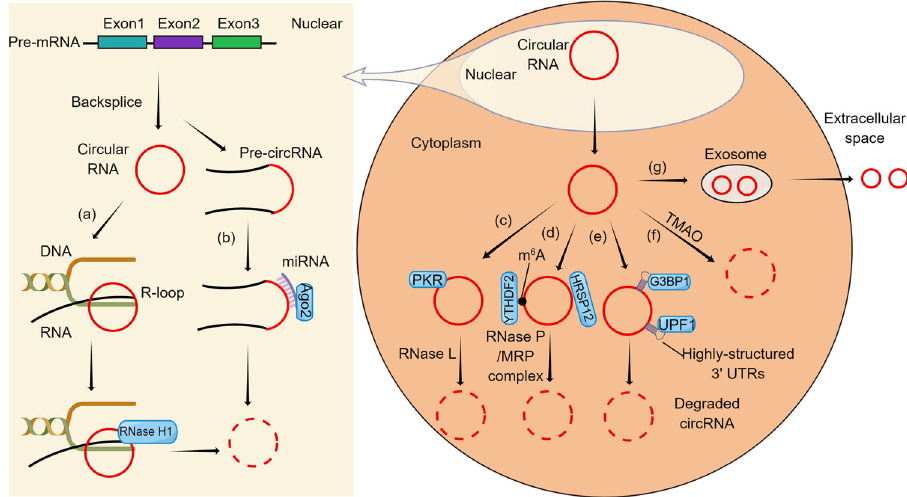
Fig. 1 A model that shows several pathways of circRNAs degradation by Figdraw (www. fi gdraw.com). a RNase H1-mediated circRNA degradation; b Ago2-mediated circRNA degradation; c RNase L-mediated circRNA degradation; d m 6 A-mediated circRNA degradation; e structure-mediated circRNA degradation; f TMAO-mediated circRNA degradation; g exosome-mediated circRNA